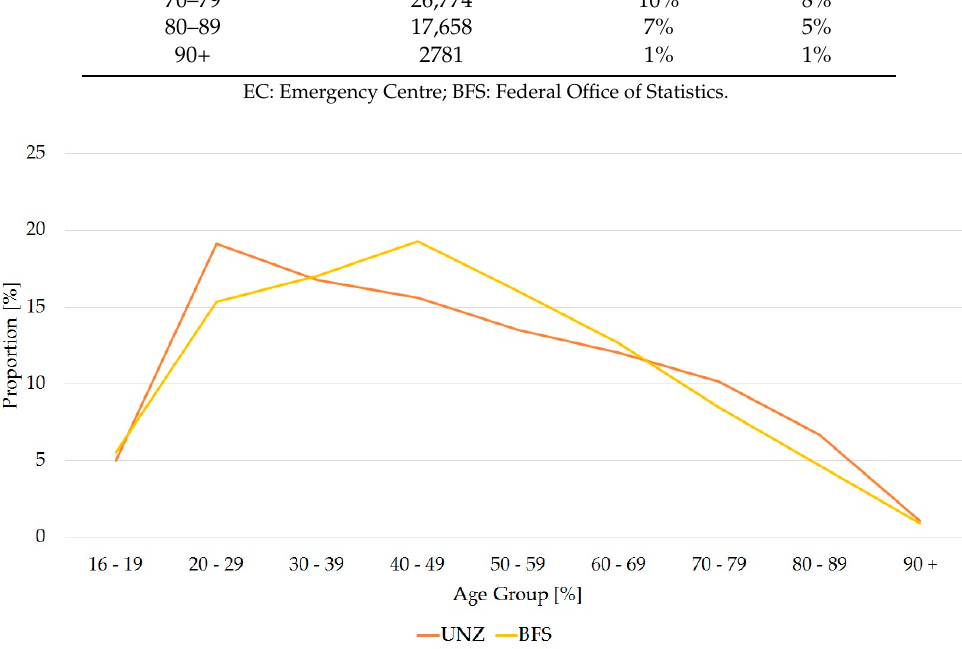
Figure 2. Percentage distribution of the age groups (years) of the permanent Swiss population, compared with Emergency Centre patients (permanent Swiss population 2004–2013, n = 53,072,512 persons (UNZ); Emergency Centre patients, n = 264,272 persons (BFS).